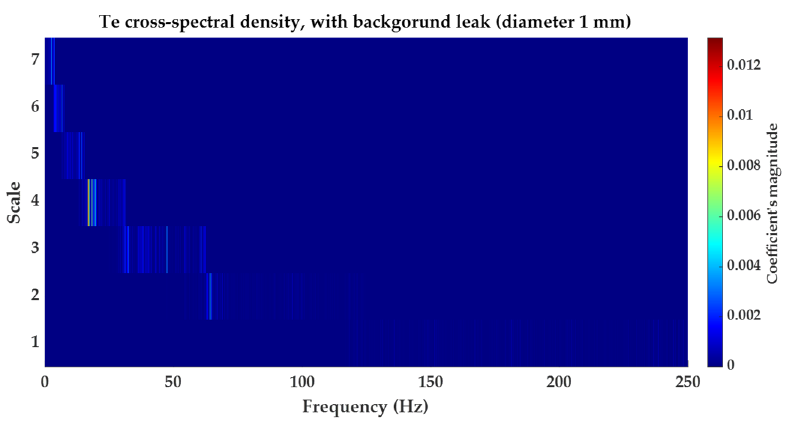
Figure 12. T e cross-spectral density, with background leak (1 mm in diameter) and flow rate Figure 12. 𝒯 (cid:3032) cross-spectral density, with background leak ( 1 mm in diameter) and flow rate 33.7 mL/s. 33.7 mL/s .